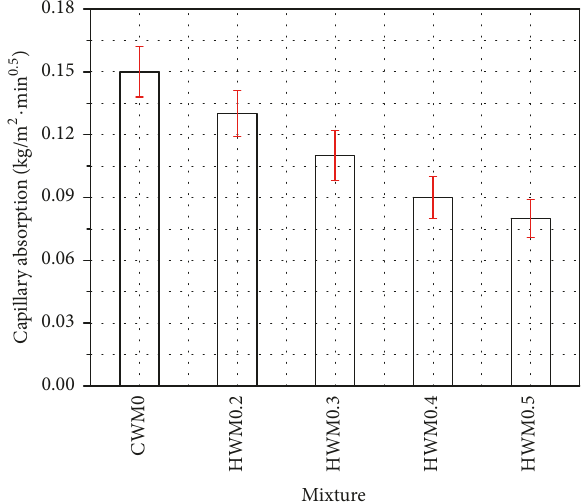
Figure4:Capillaryabsorptioncoefficientsofmortarmixturesatthe curing age of 28